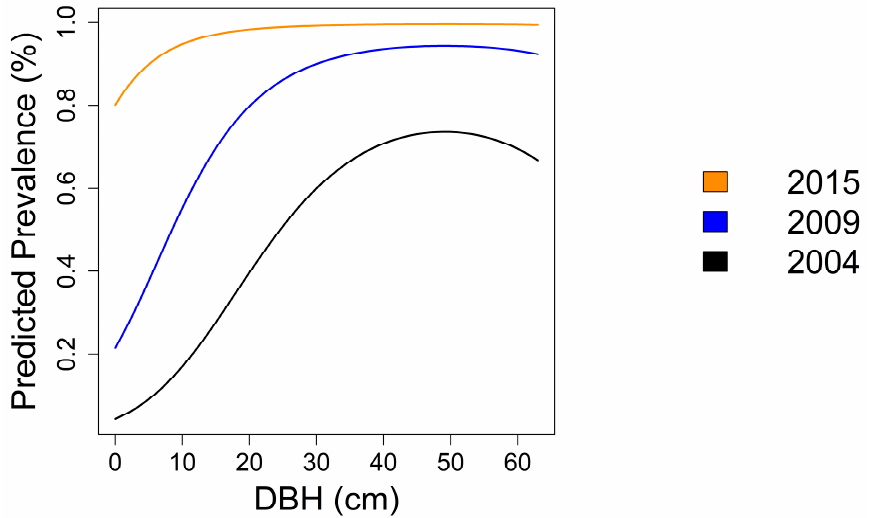
Figure 7. Model predicted prevalence across range of tree diameters (dbh in cm) for each study year.